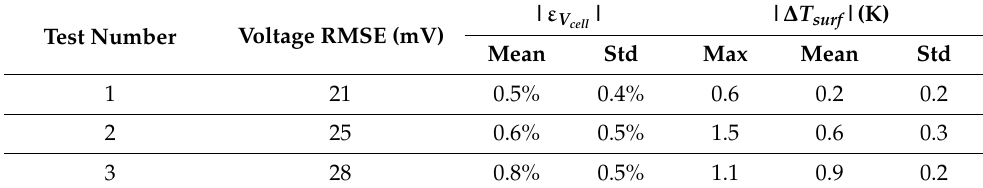
Table 6. Validation tests results.